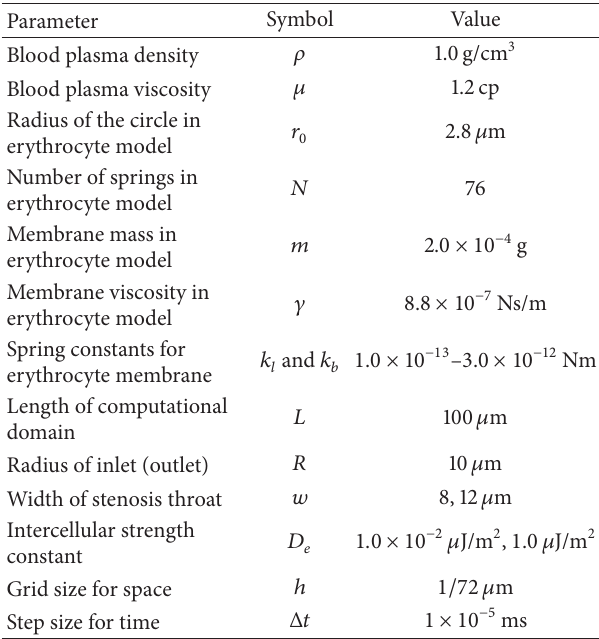
Table 1: Parameters used for the